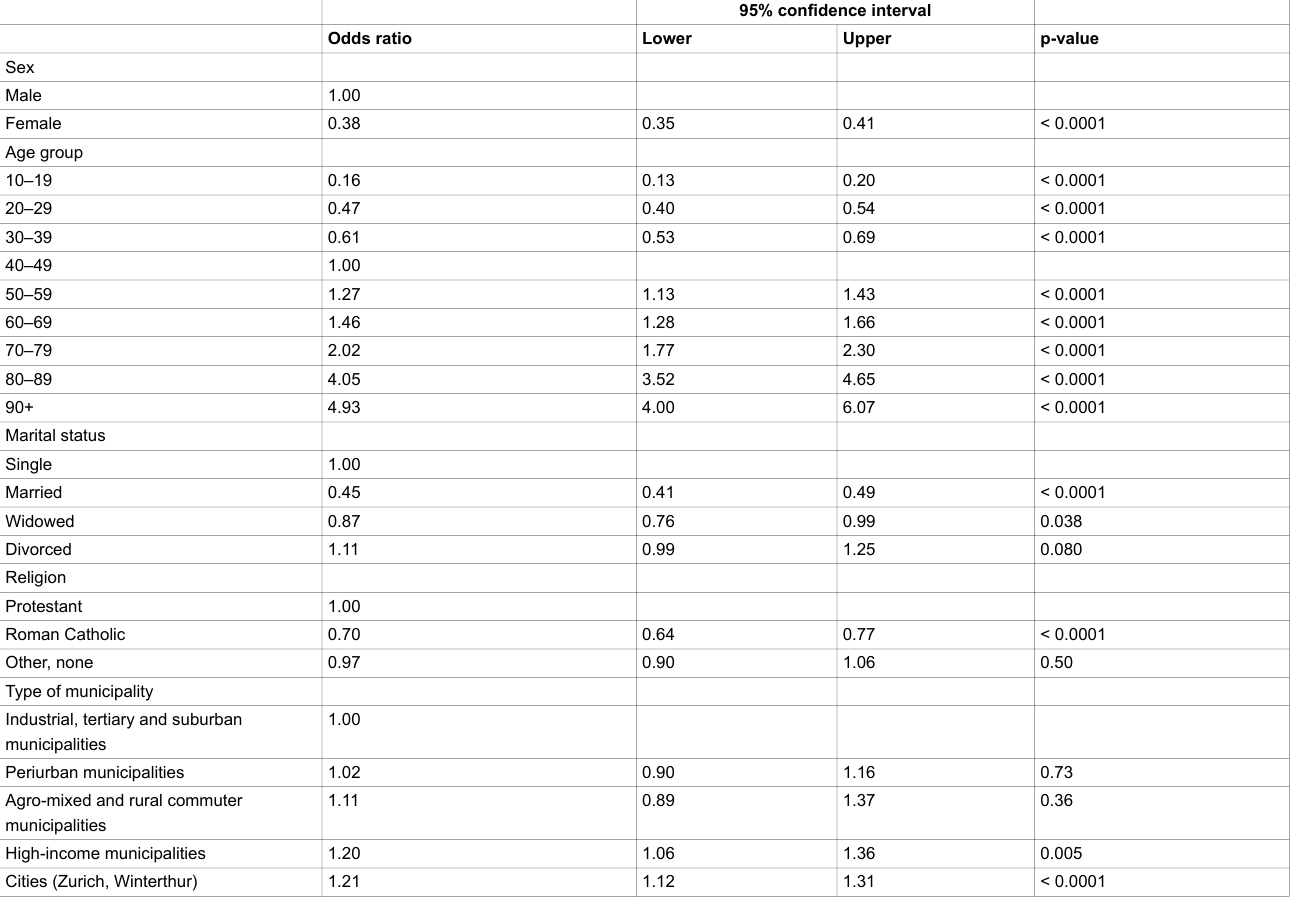
Table 1 Influence of sex, age, marital status, religion and place of residence on the suicide risk, in the Canton of Zurich (suicide victims 1995–2007 compared to population